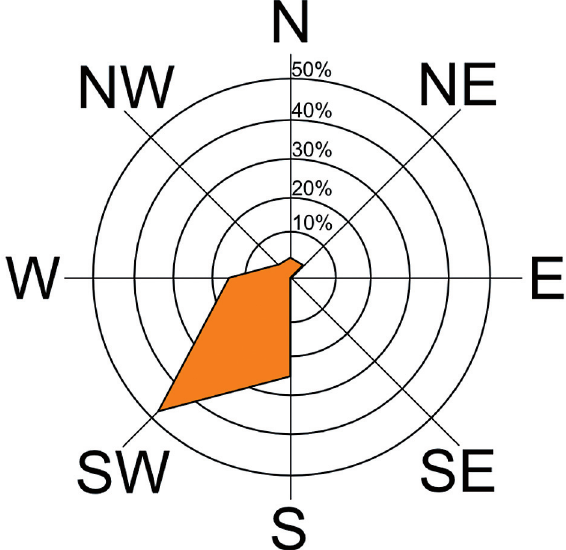
Fig. 5. Air mass advection direction measured at the 500 hPa level during days when the large hail in 2012 in Poland was reported (based on reports from ESWD and soundings from Legionowo